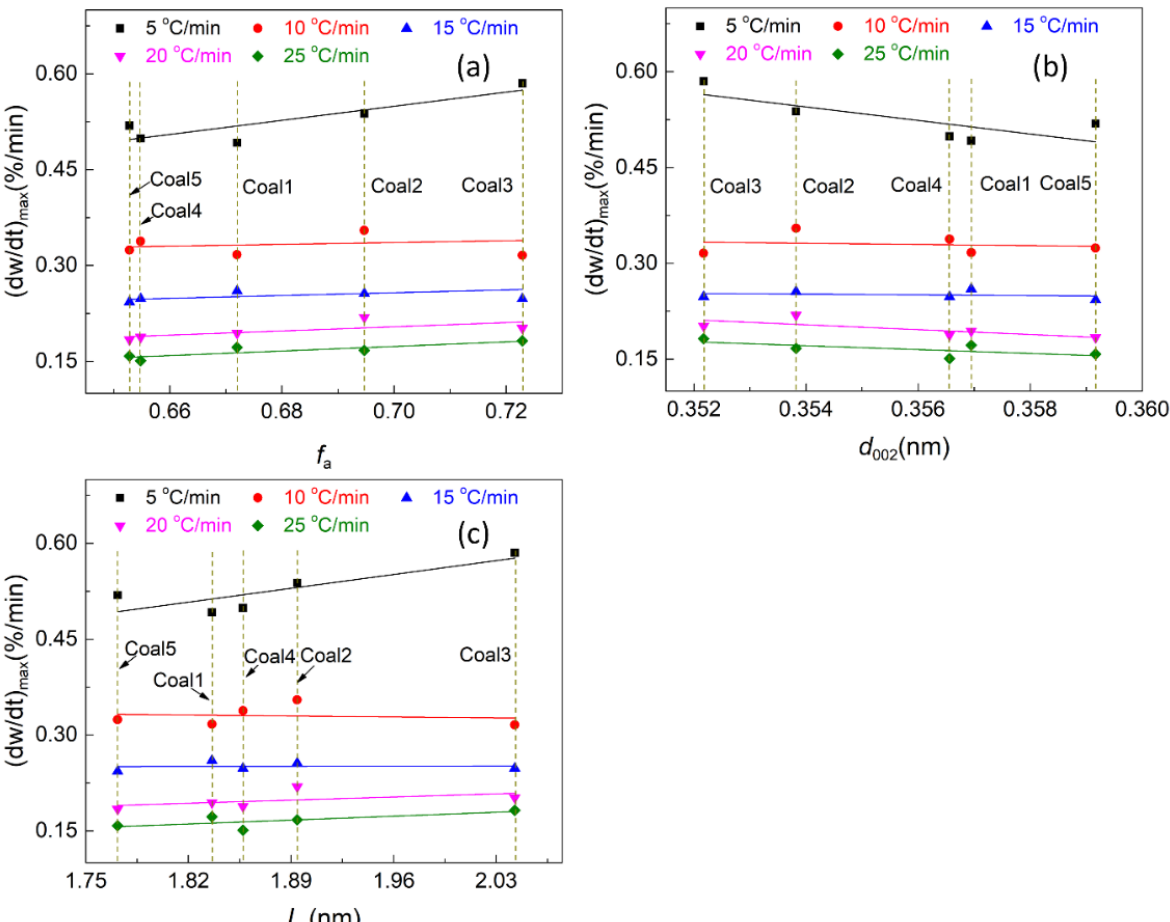
Figure 8. Relationship between maximum combustion rate and coal structure from XRD analysis: